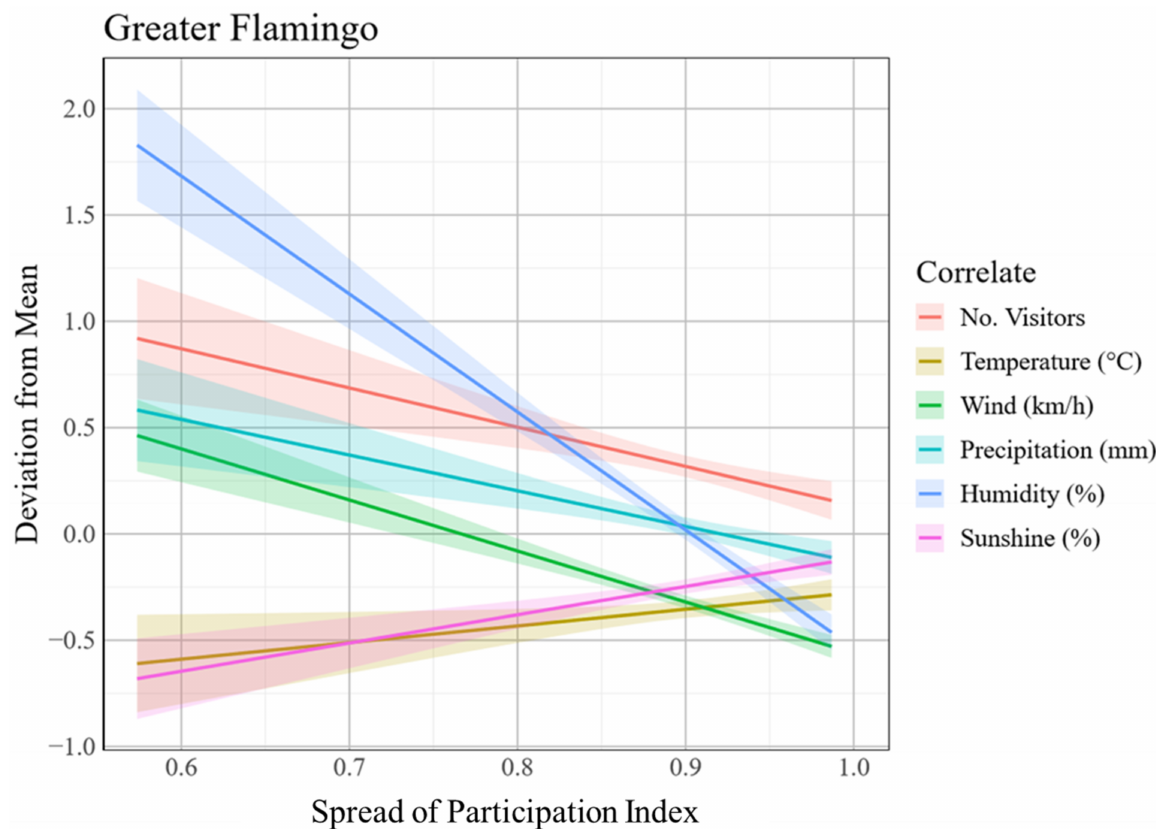
Figure 8. Correlation between Spread of Participation Indices (SPI) of Greater Flamingos during the zoo open condition and visitor and environmental variables. Correlates were centred around the mean. Intercept = mean. Shaded areas around lines represent ± 95% CI. An increase in visitor number, wind, precipitation, and humidity was associated with a less widespread use of the enclosure. An increase in temperature and sunshine were associated with a wider use of